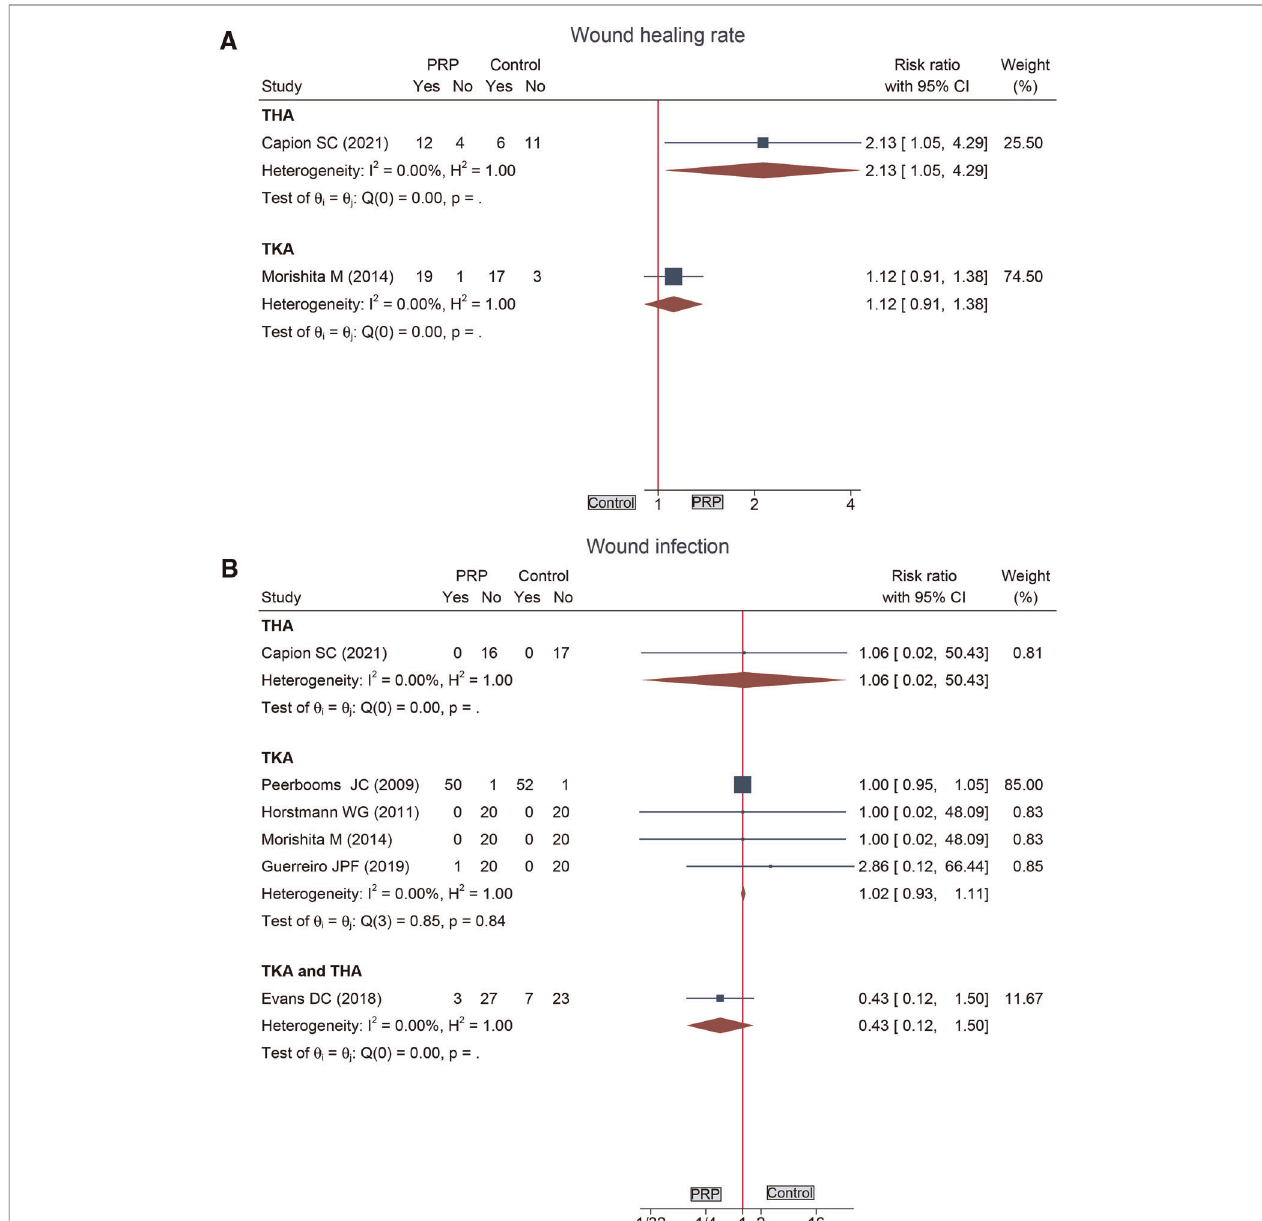
FIGURE 7 | Forest plot presents the pooled results for: ( A ) wound healing rate; ( B ) wound